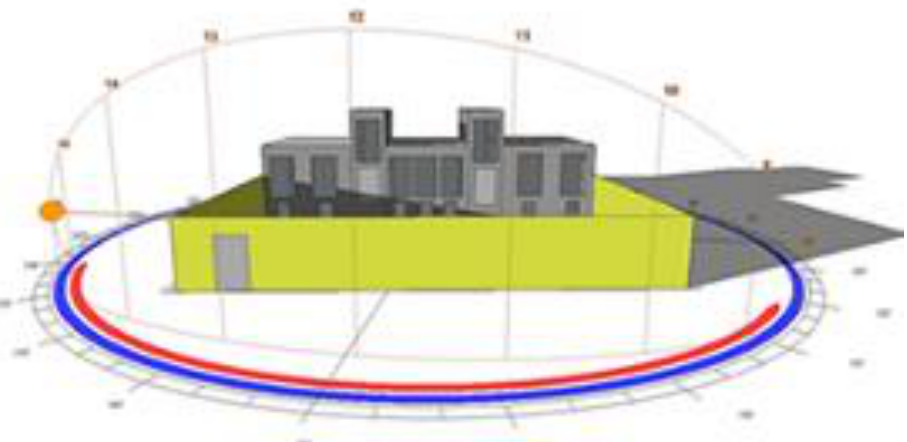
Figure 21 3D view of house No.5 (January, 16:00 pm)